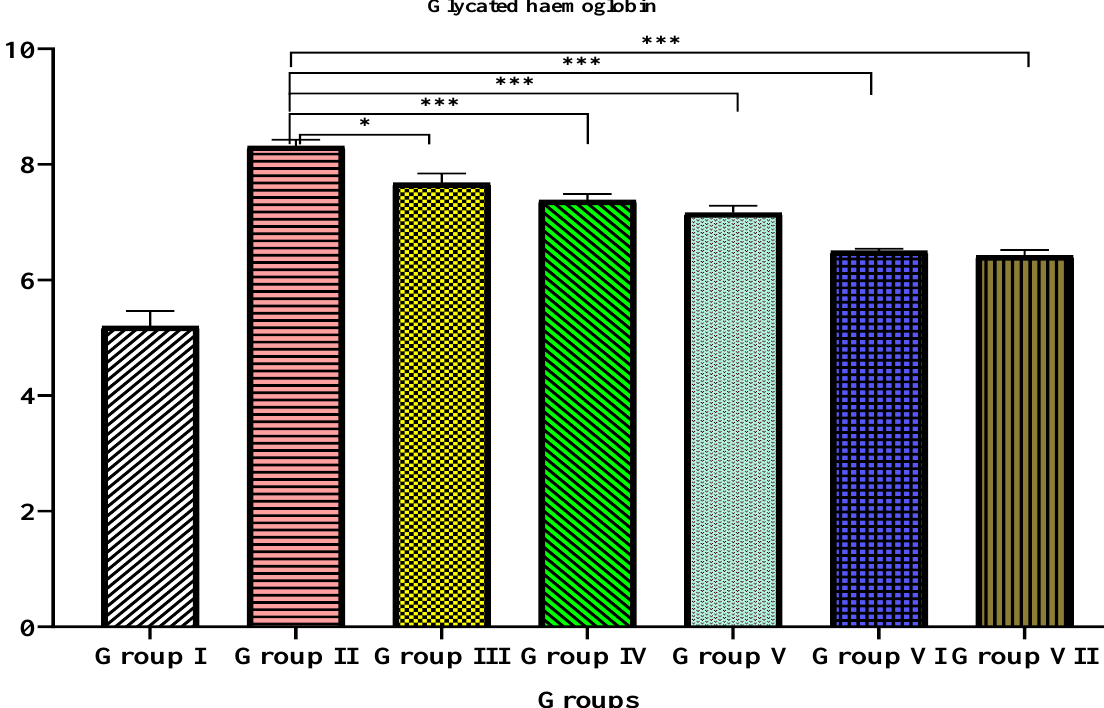
Figure 9. In STZ-induced diabetic rats, the effects of TPE, TPZnO NPs, and glibenclamide on glycated hemoglobin. Group I: Normal control (0.1% CMC suspension); Group II: Diabetic control (received STZ 55 mg/Kg bw); Group III: TPE (100 mg/Kg bw); Group IV: TPE (200 mg/Kg bw) treatment; Group V: TPE-mediated ZnO NPs (100 mg/Kg bw); Group VI: TPE-mediated ZnO NPs (200 mg/Kg bw); Group VII: Glibenclamide (10 mg/Kg bw). Values are expressed as mean ± SEM, ( n = 6); p < 0.033 (*), p < 0.001 (***) compared to diabetic animals/Group II (two-way ANOVA followed by a Dunnett’s t -test).